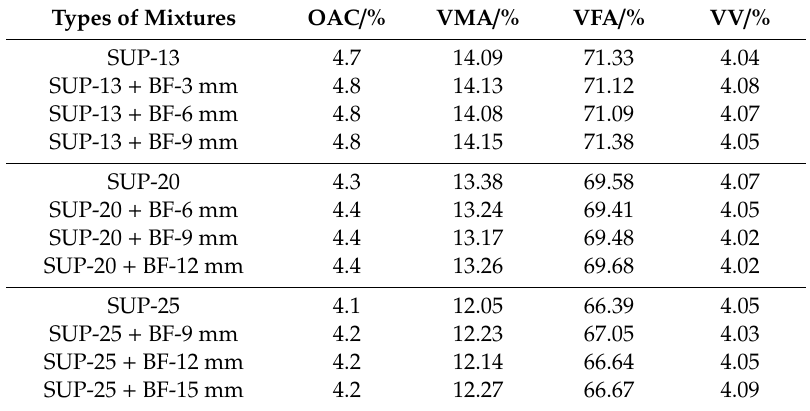
Table 3. Optimum asphalt content (OAC) and volumetric properties.